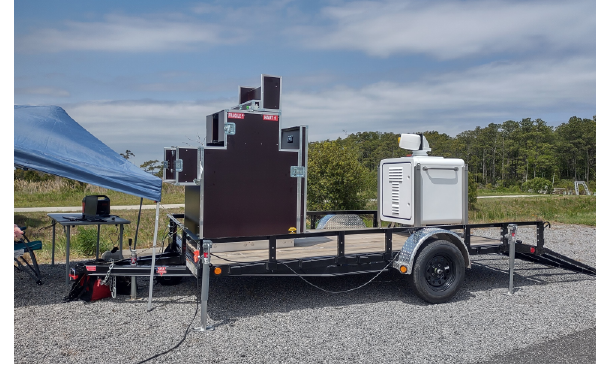
Figure 6: RHI scan with 25 m range gate showing radial wind speed up to a 30 ∘ elevation and 150 m